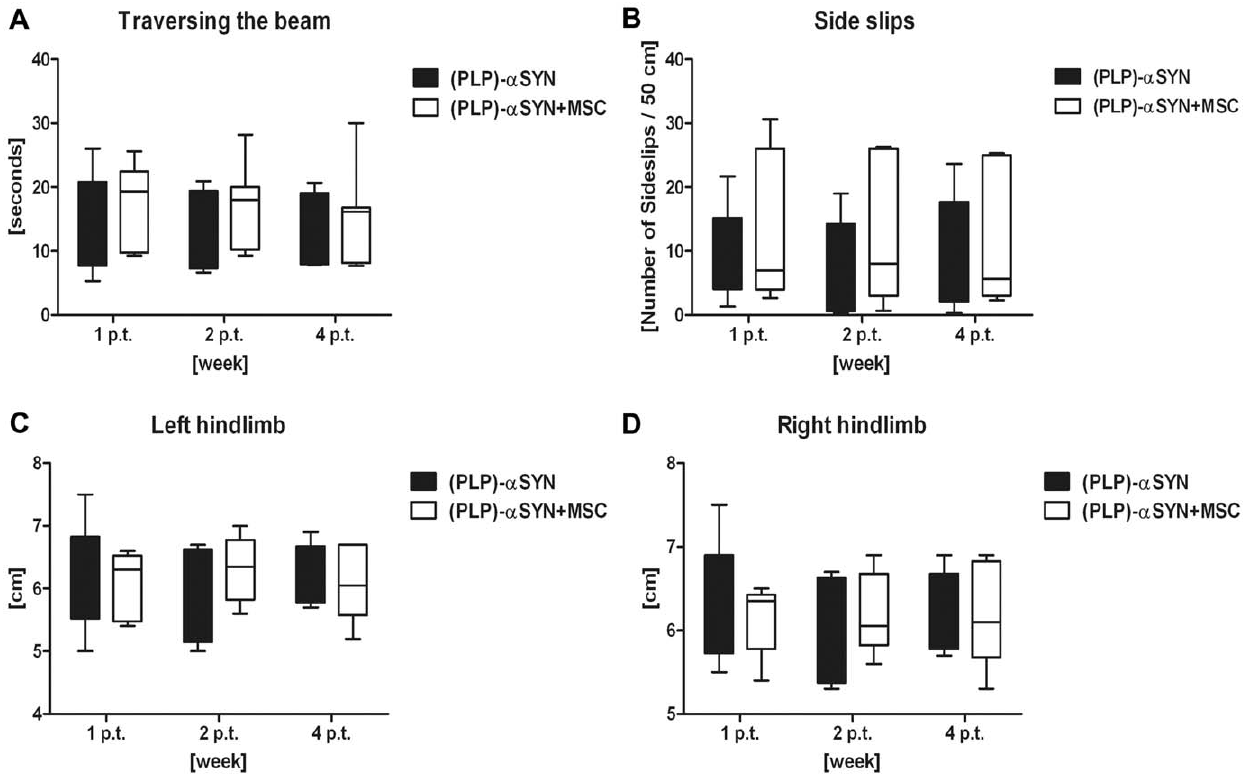
Figure 2. Assessing motor coordination with the beam walking test and DigiGait analysis. Duration to traverse a narrow beam analysed 1 week, 2 weeks and 4 weeks post transplantation (p.t.) ( A ). No difference between (PLP)- a SYN (n=6) and (PLP)- a SYN + MSC (n=7) treated animals was found (p . 0.05). Number of side slips traversing a 50 cm narrow beam was analysed at 1 week, 2 weeks and 4 weeks p.t. ( B ). Statistical analysis did not reveal any significant difference between both groups. Stride length analysis of left ( C) and right ( D ) hindlimbs of (PLP)- a SYN + MSC (n=7) versus (PLP)- a SYN controls (n=6), 1 week, 2 weeks and 4 weeks p.t. Stride length did not significantly alter in MSC treated animals compared to saline treated controls (p . 0.05). Data were analysed by two-way ANOVA, following Bonferroni post-hoc test (for multiple corrections) and are presented as means 6 SEM. Statistical significance was set at p , 0.05.